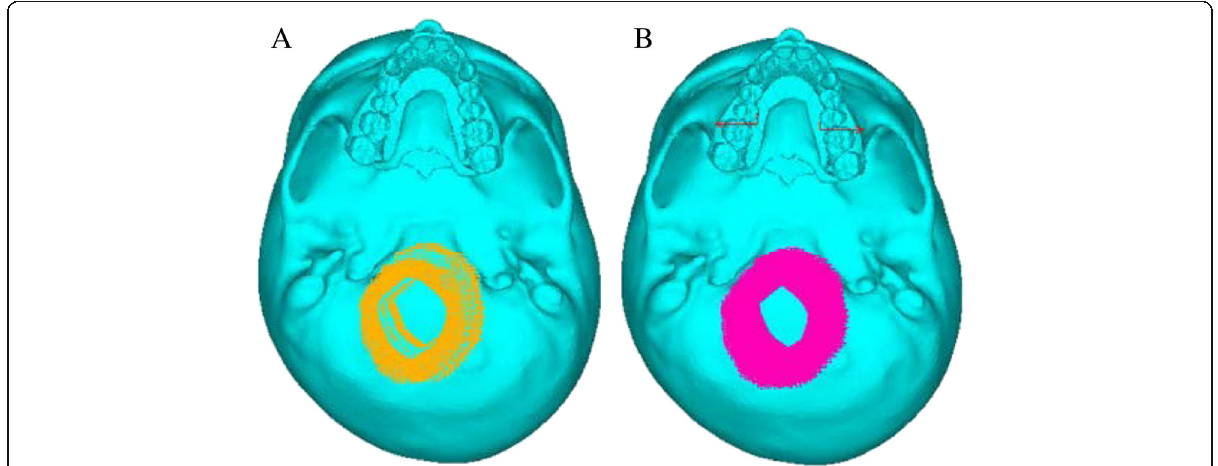
Fig. 5 Boundary conditions of the finite element model. a Without implants. b With